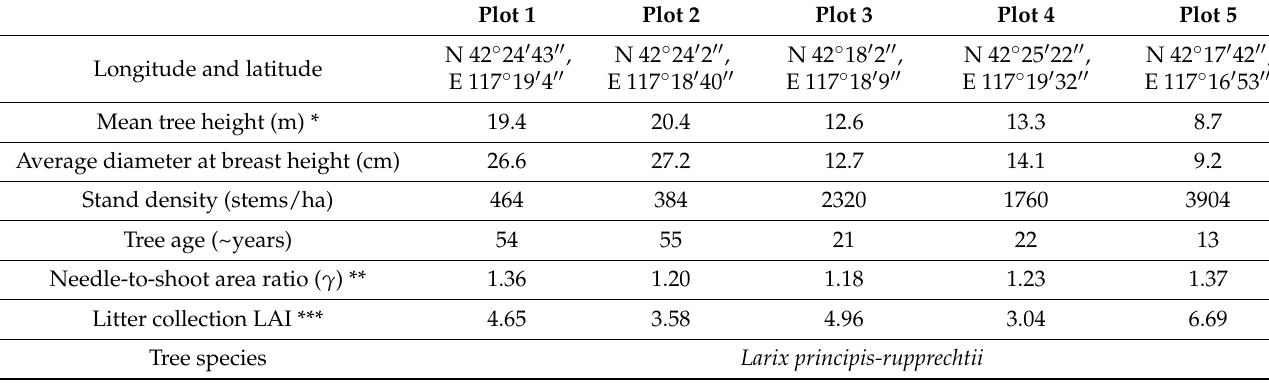
* The height of each tree in each plot was estimated based the point cloud dataset collected using the terrestrial laser scanner in the 2017 leaf area index (LAI) measurement campaign [31]. The height of each tree was calculated as the vertical distance between the highest point of the tree and the lowest point of the stem located close to the ground [31]. ** The needle-to-shoot area ratio ( γ ) of each plot was estimated by averaging the γ of typical shoot samples harvested from the three height levels of forest canopies (i.e., top, middle, and bottom). Details of γ estimation can be found in Section 2.3.3. *** The litter collection LAI of the five plots was obtained by using the litter collection measurements acquired in the 2017 LAI measurement campaign